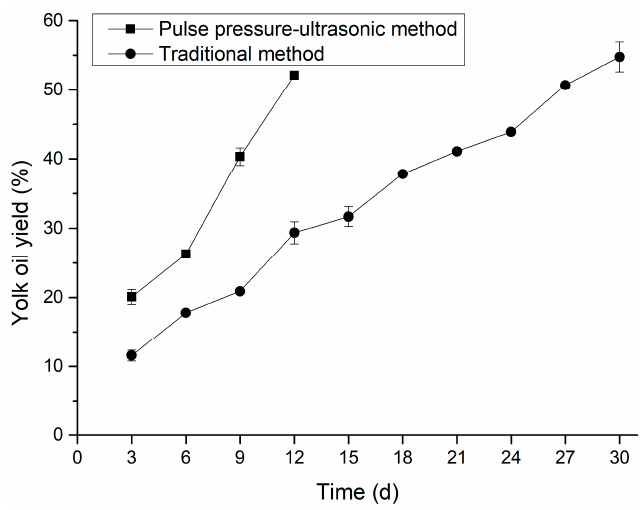
Figure 3. Comparison of yolk oil yield.